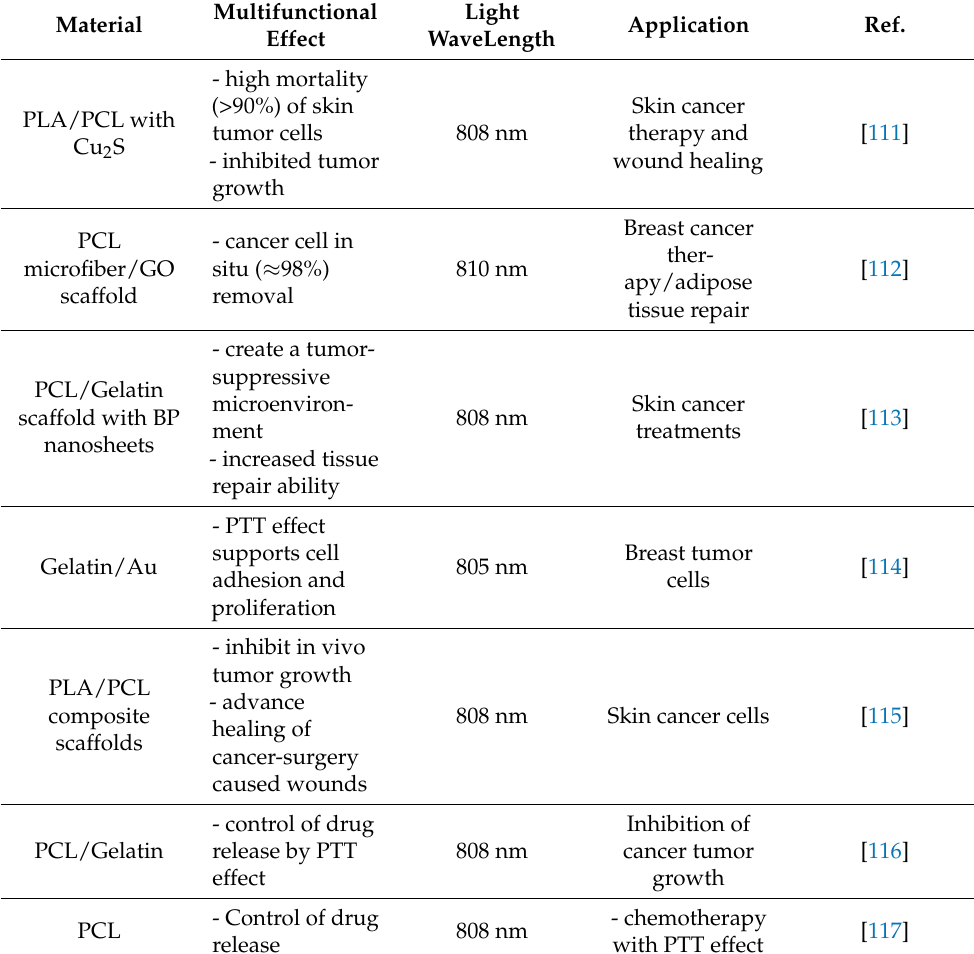
Table 2. Electrospun scaffolds combined with PTT